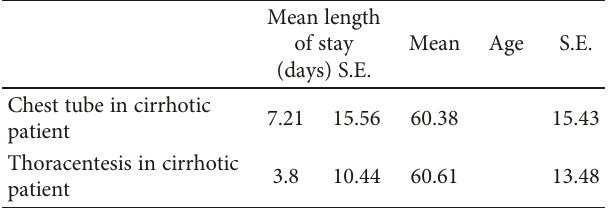
Table 3: Length of